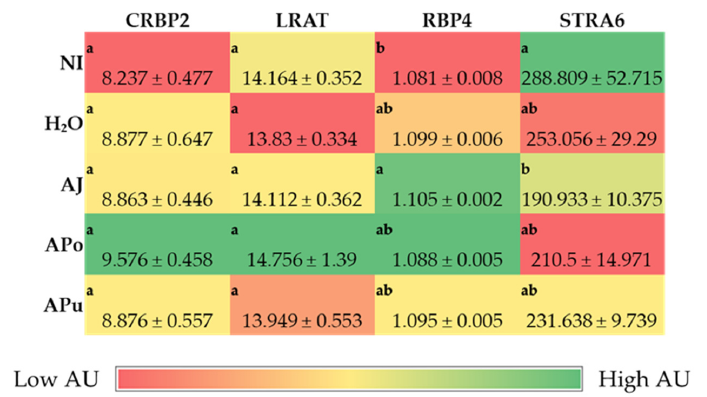
Figure 2. Effect of intra-amniotic administration of apple fraction soluble extracts on vitamin A intestinal (CRBP2 and LRAT) gene expression and hepatic (RBP4 and STRA6) metabolic proteins. Values are the means ± SEM, n = 5. a, b Treatment groups not indicated by the same letter in the same column are significantly different ( p < 0.05) by Duncan’s post-hoc test. CRBP2, Cellular retinol- binding protein 2; LRAT, Lecithin: Retinol Acyltransferase; RBP4, Retinol binding protein 4; STRA6, Stimulated by Retinoic acid 6; AU, Arbitrary